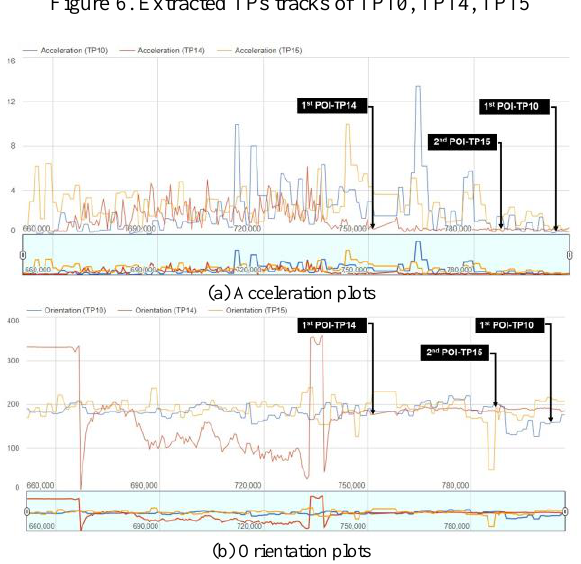
Figure 7. Sample of sensor data plot for corresponding TP 10, TP 14, and TP 15 against their targeted POIs.